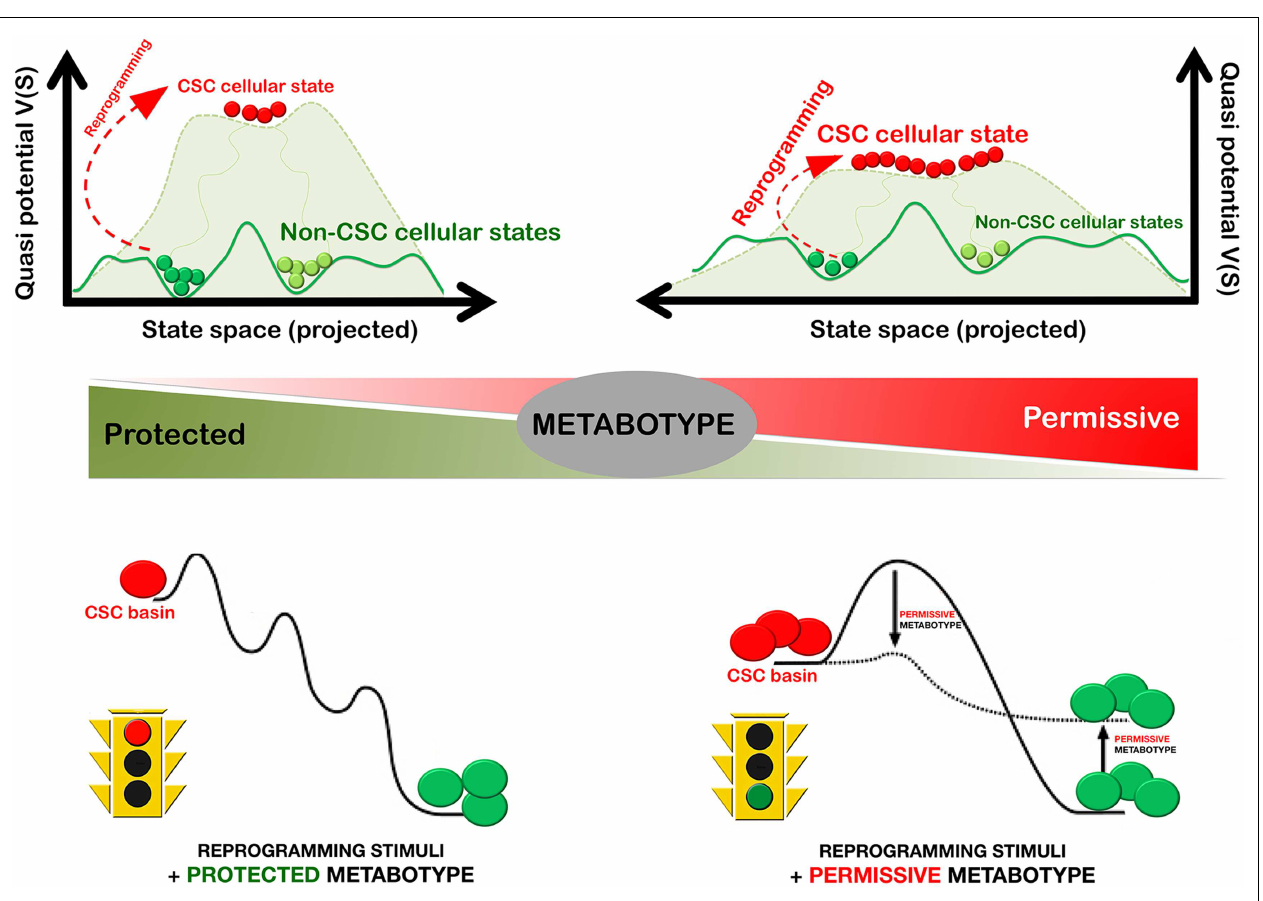
landscape and by increasing the size of the basin of attraction of CSC cellular states. In this scenario, even modest changes in the protected versus permissive nature of the cellular metabotype are expected to produce a considerable change on the kinetic efficiency of the reprograming